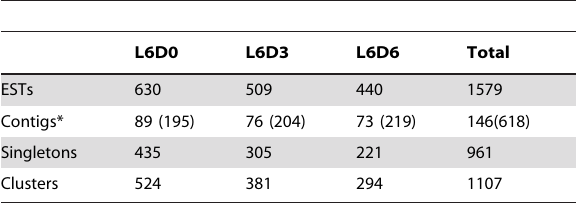
Table 2. Numbers of assembled S. litura midgut ESTs